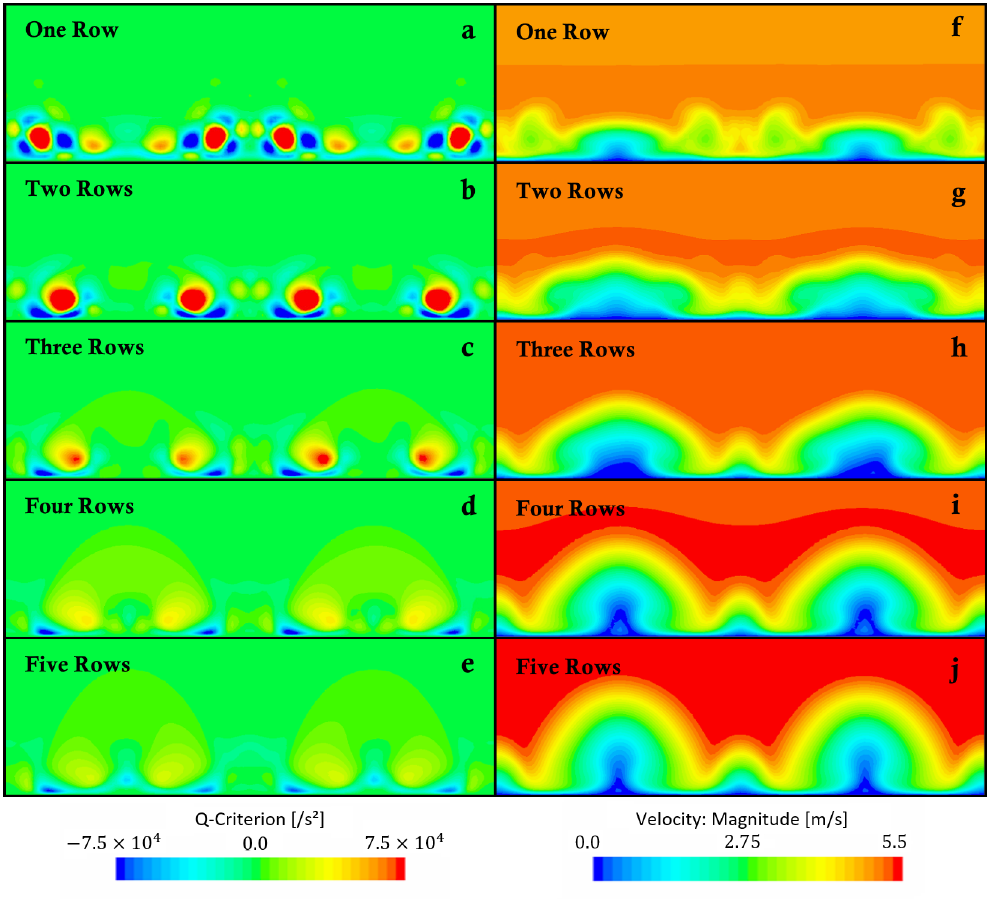
Figure 20. Q-criterion and velocity for between one and five knitted wire rows at X/H 2 = 11.5, 13.17, 14.83, 16.5 and 18.17, respectively. The X values represent the same distance downstream in the wake of the different wire